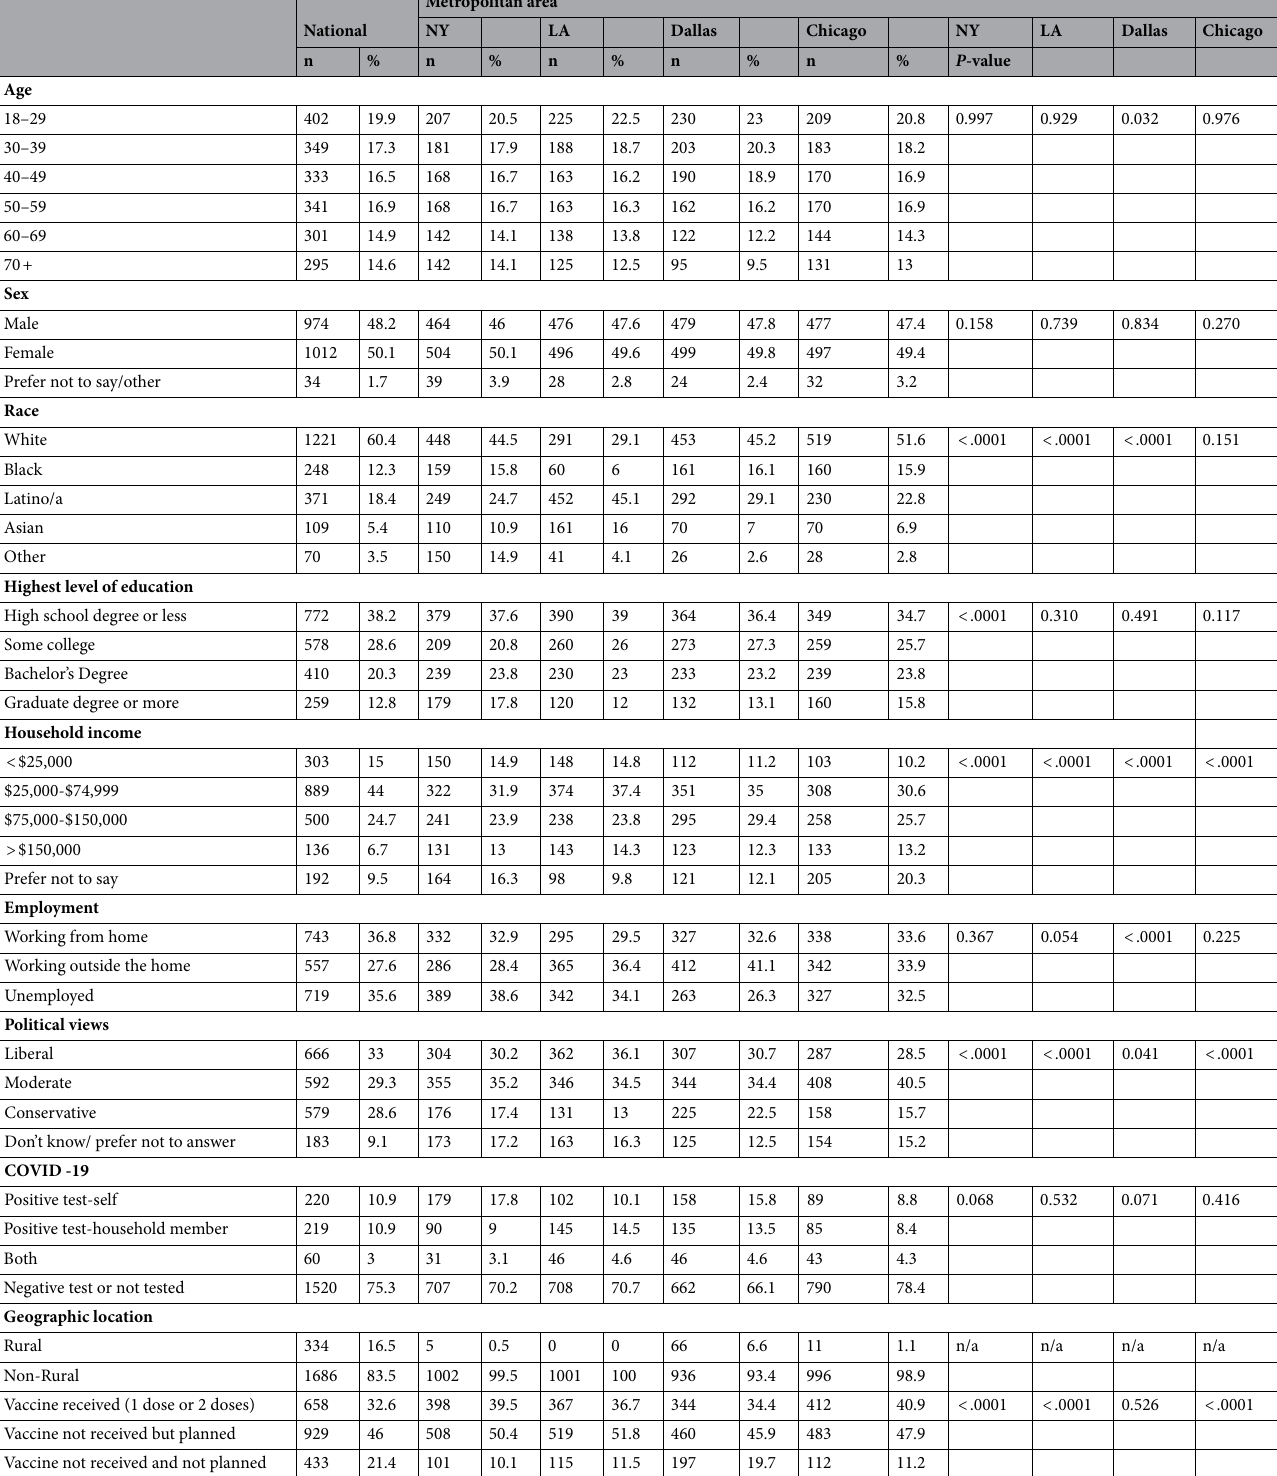
Table 1. Demographics and COVID-19 vaccine intention or uptake in each of the five samples. n, % are weighted to the geographic population; P -values are based on weighted chi-squared tests comparing each metropolitan areas to the national